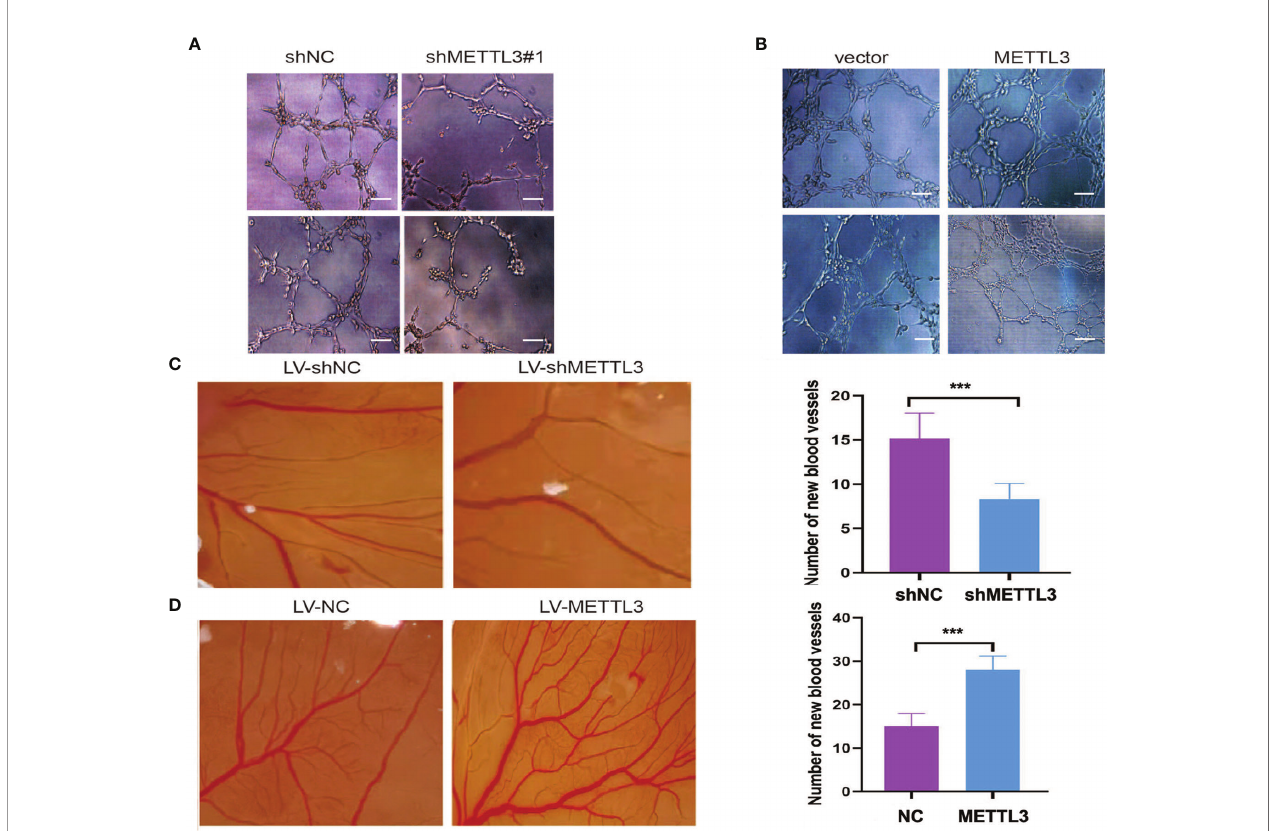
FIGURE 3 | METTL3 promoted GC angiogenesis. (A, B) HUVECs cultured with medium obtained from GC cells with METTL3 de fi ciency or overexpression. (C) Representative images of the CAM experiment from LV-shMETTL3 and LV-shNC group. (D) Representative images of the CAM experiment from LV-METTL3 and LV-NC group. The average number of new vessels was quanti fi ed. Scar bar = 50 m m, ***P <